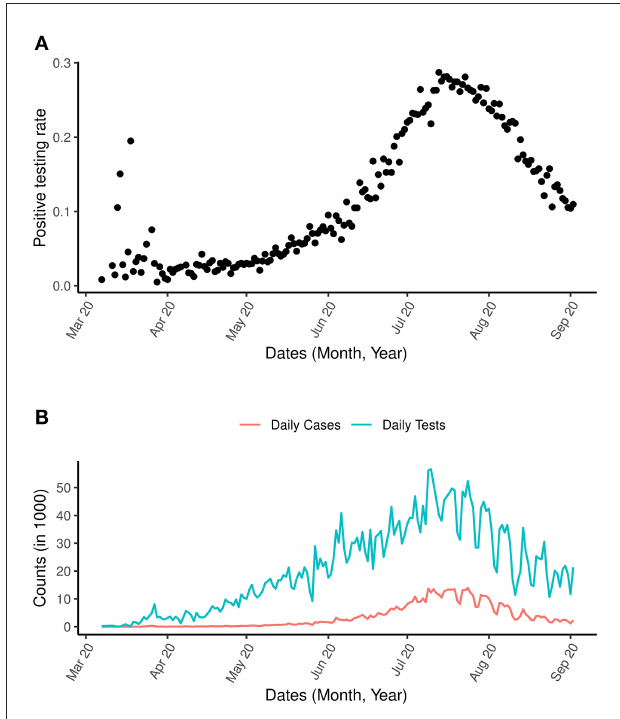
FIGURE2 COVID-19 and positive testing rate. (A) Is the positive testing rate. (B) Is the daily number of cases and daily number of COVID-19 tests between March 7th, 2020 and September 2nd,